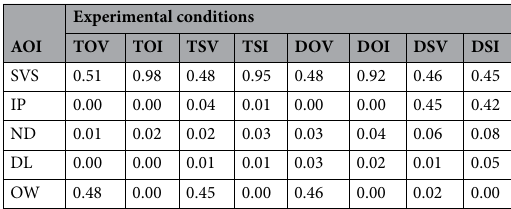
Table 11. Fixation probabilities of each AOI in each experimental condition predicted by the step-by-step prediction model.